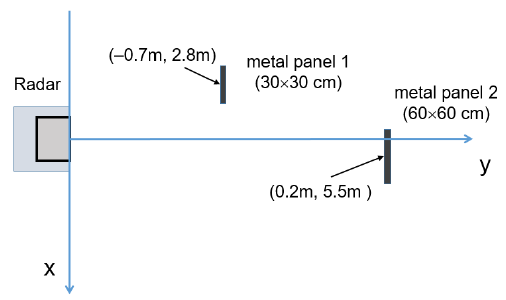
Figure 20. Sketch of the experimental investigated scenario with two square metal panel targets: metal panel 1 (30 × 30 cm) and metal panel 2 (60 × 60 cm).